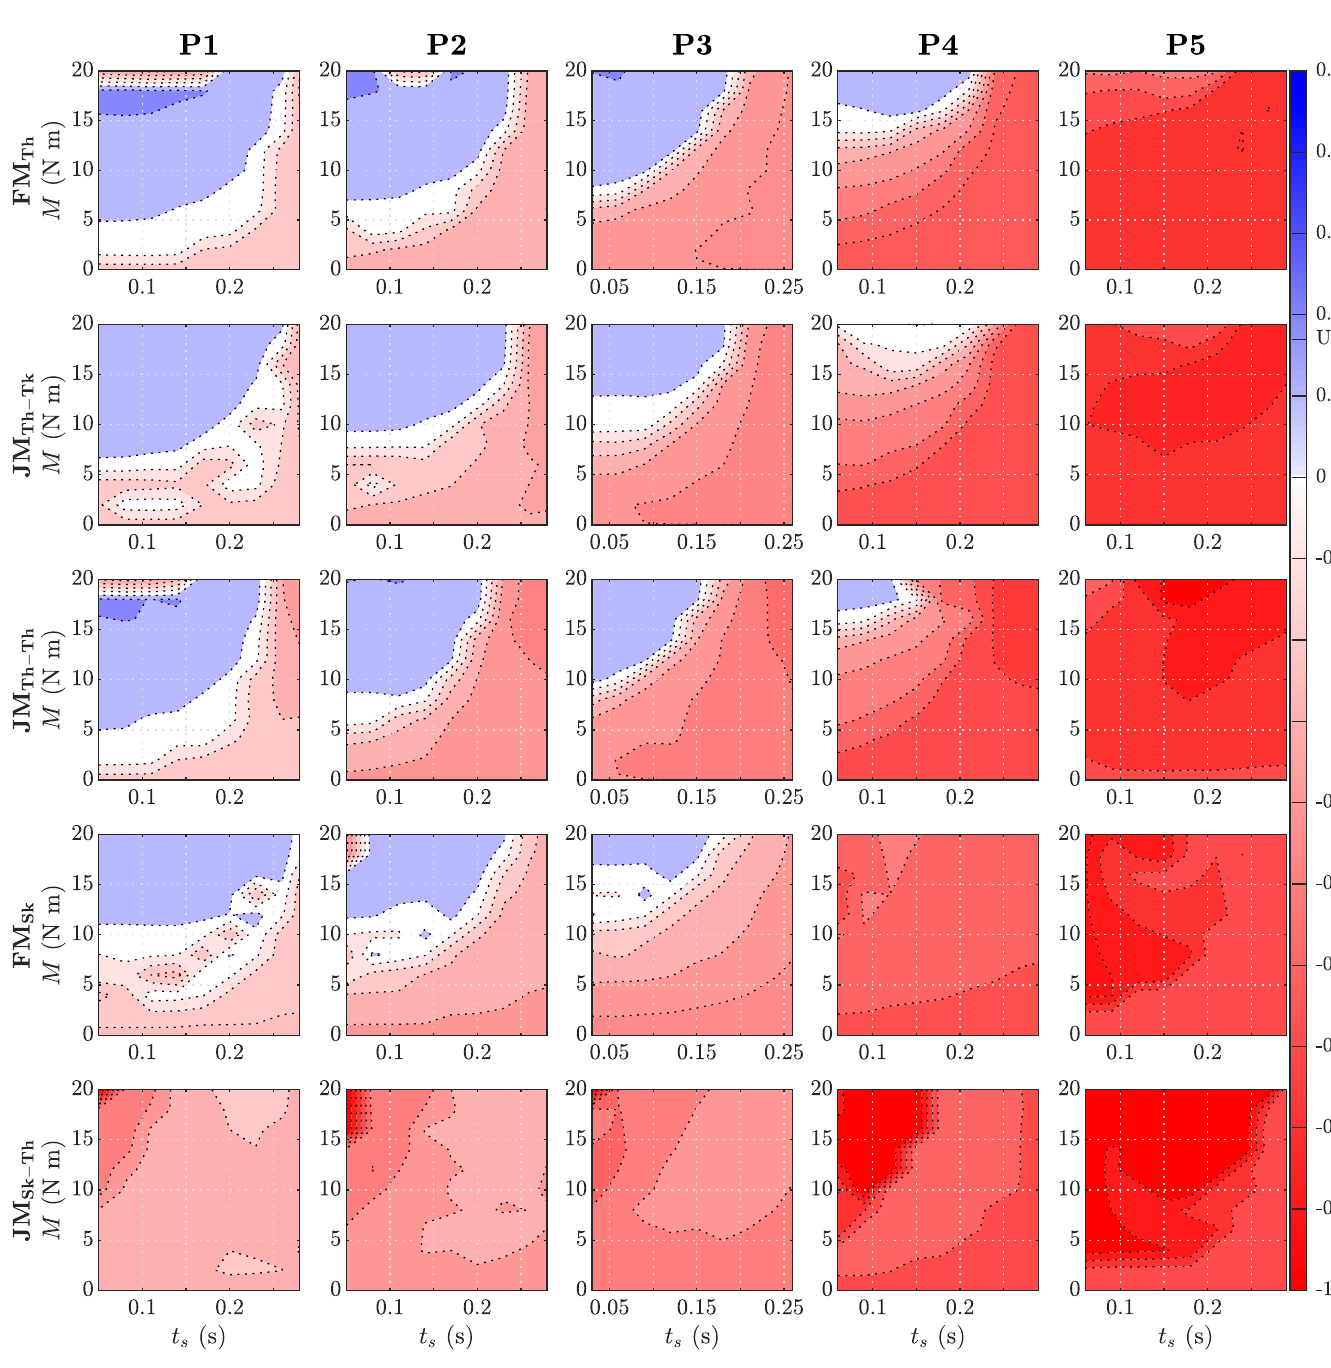
PLOS ONE | https://doi.org/10.1371/journal.pone.0280158 February 21,